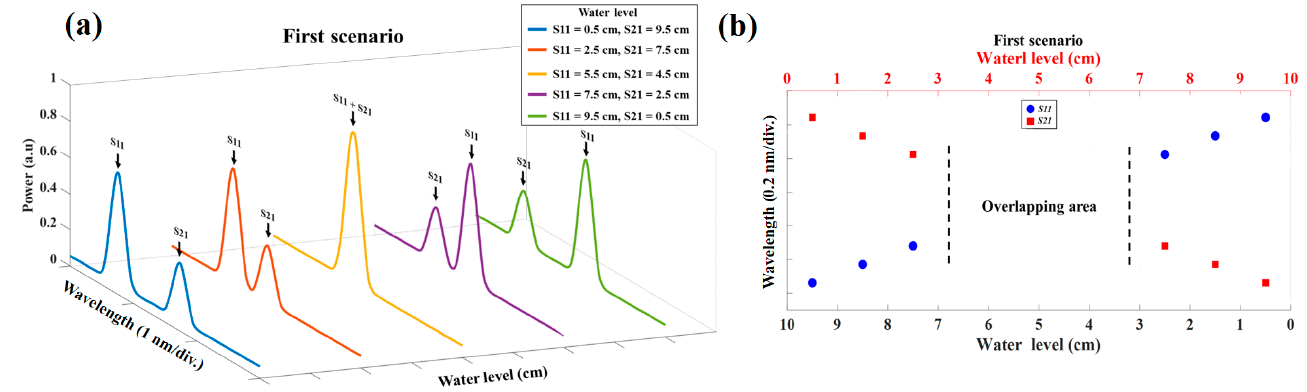
Figure 4. ( a ) The experimental result of the reflected spectrum of two water level sensors in five different water level steps of the first scenario. ( b ) The unmeasurable overlapping gap due to the overlap of two sensor spectra in the first